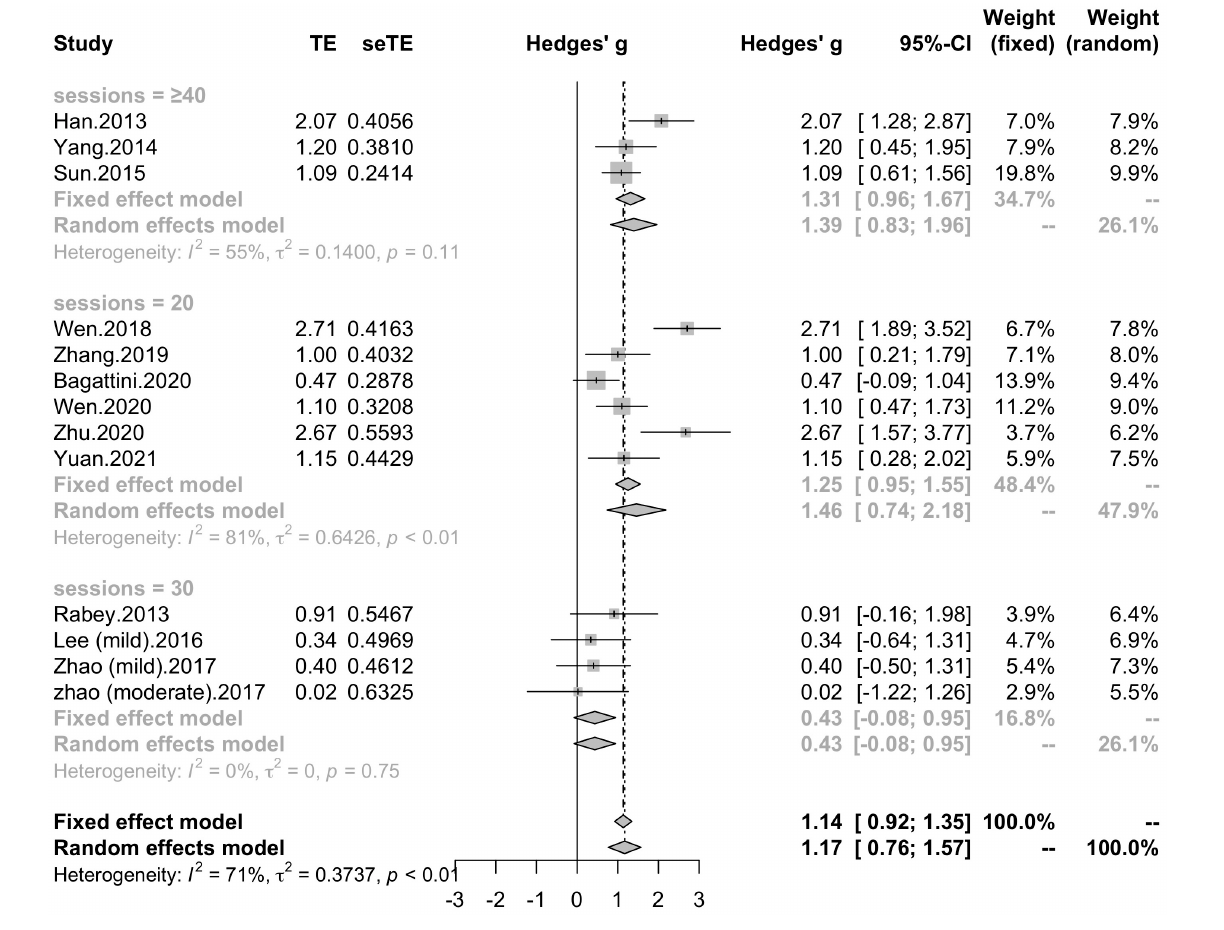
FIGURE 4 | Forest plot: mean differences in session number subgroup with 95%